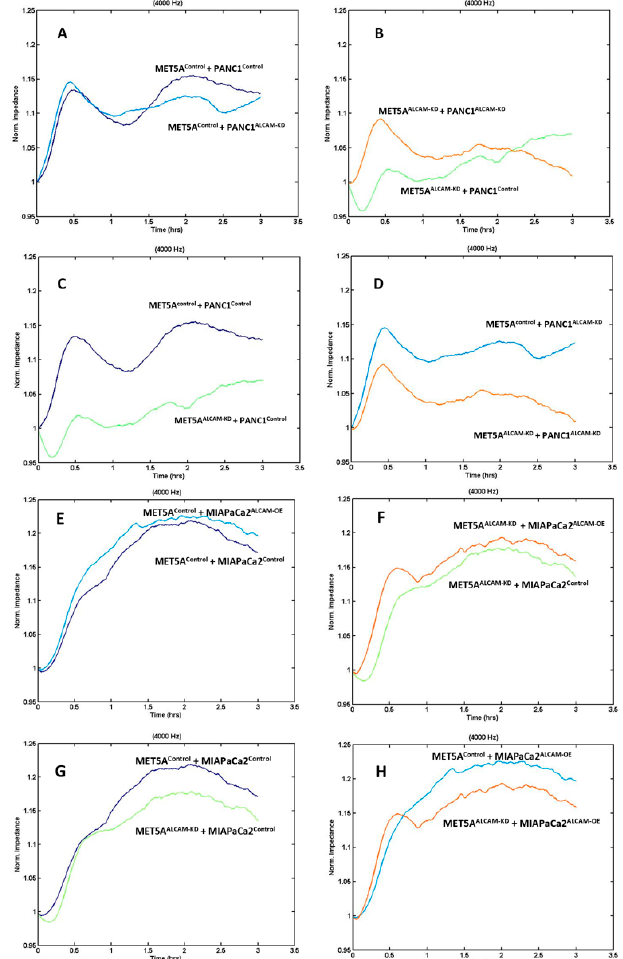
Figure 5. ECIS based evaluation of pancreatic adhesion to mesothelial cells. ( A – D ): Adhesion of PANC1 cells to MET5A mesothelial cells; ( E – H ): Adhesion of MIA PaCa-2 cells to MET5A cells. Shown are monitoring at 4000Hz. MET5A Control , PANC1 Control , MIAPaCa2 Control : control transfected Int. J. Mol. Sci. 2023 , 24 , 876 cells; MET5A ALCAM-KD , PANC1 ALCAM-KD : cells with ALCAM knockdown by way of cell transfection; MIAPaCa2 ALCAM-OE : cells with ALCAM overexpression by way of cell transfection. Replicate n = 4.